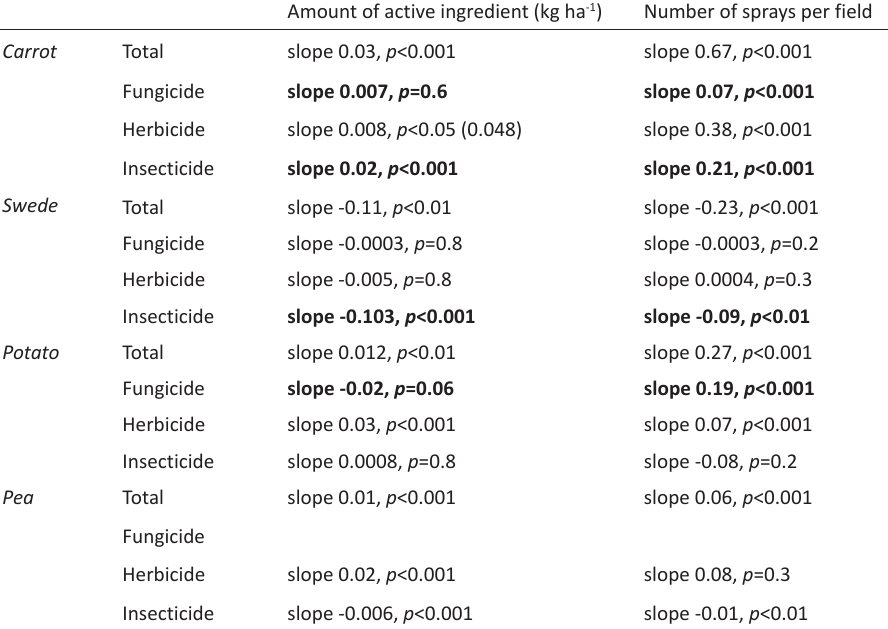
Table 5. The change in trends (slopes and p -values) for amount of active ingredient (kg ha -1 ) of PPPs and number of sprays per field in carrot, swede, potato and pea crops in 2003–2019. The largest differences between amounts and spray frequencies are in bold. Amount of active ingredient (kg ha -1 ) Number of sprays per